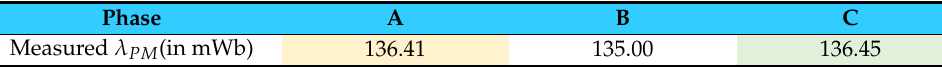
Figure 4. FFT of phase voltage at a speed of 1708 r/min. Table 2. The measured flux linkage of PMs ( λ PM ).